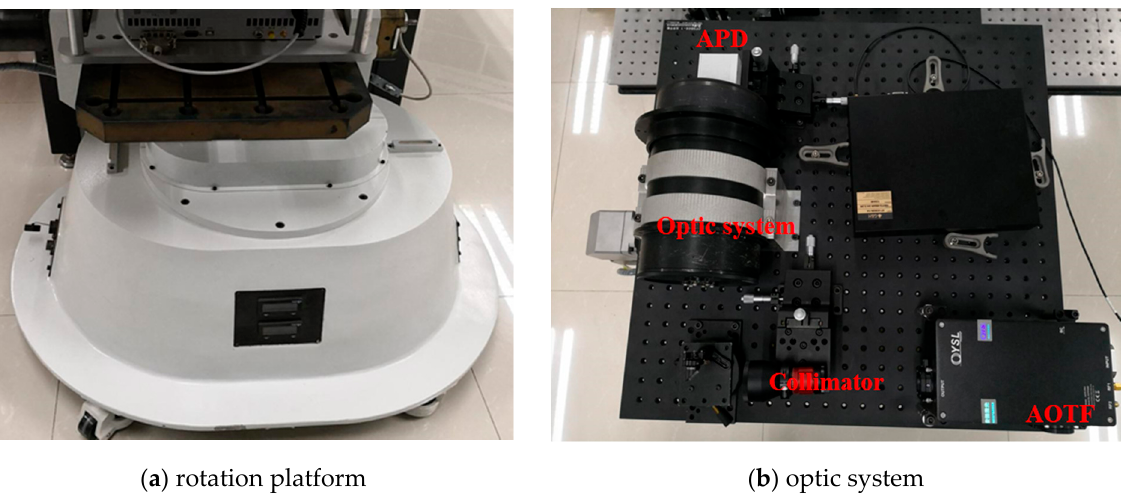
Figure 2. A 2D rotation platform and the AOTF-HSL hardware prototype .